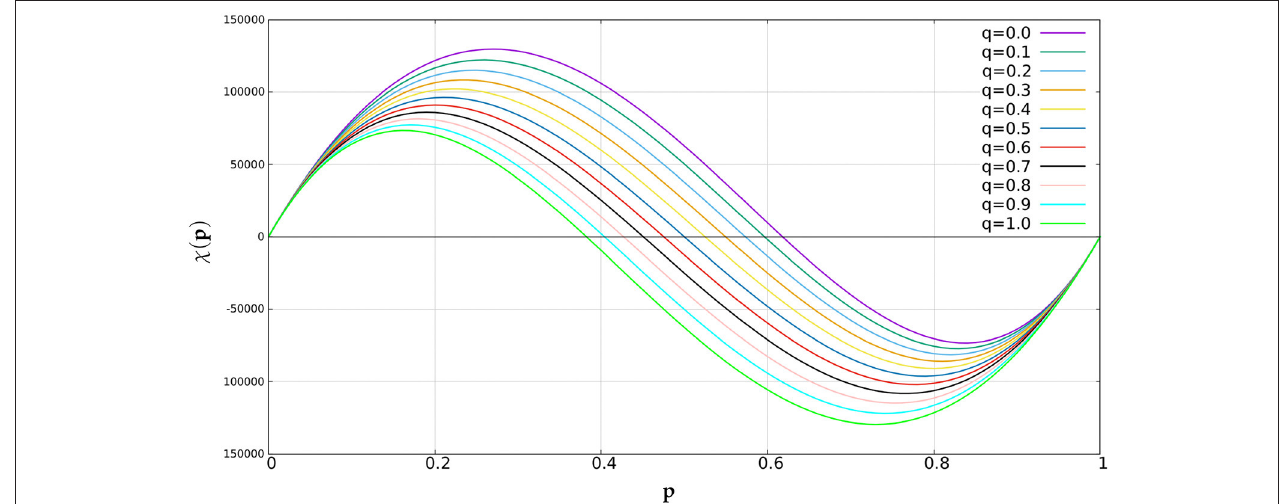
FIGURE 2 | Variation of Euler number χ ( p ) with site occupation probability p for different values of diagonal connection probabilities